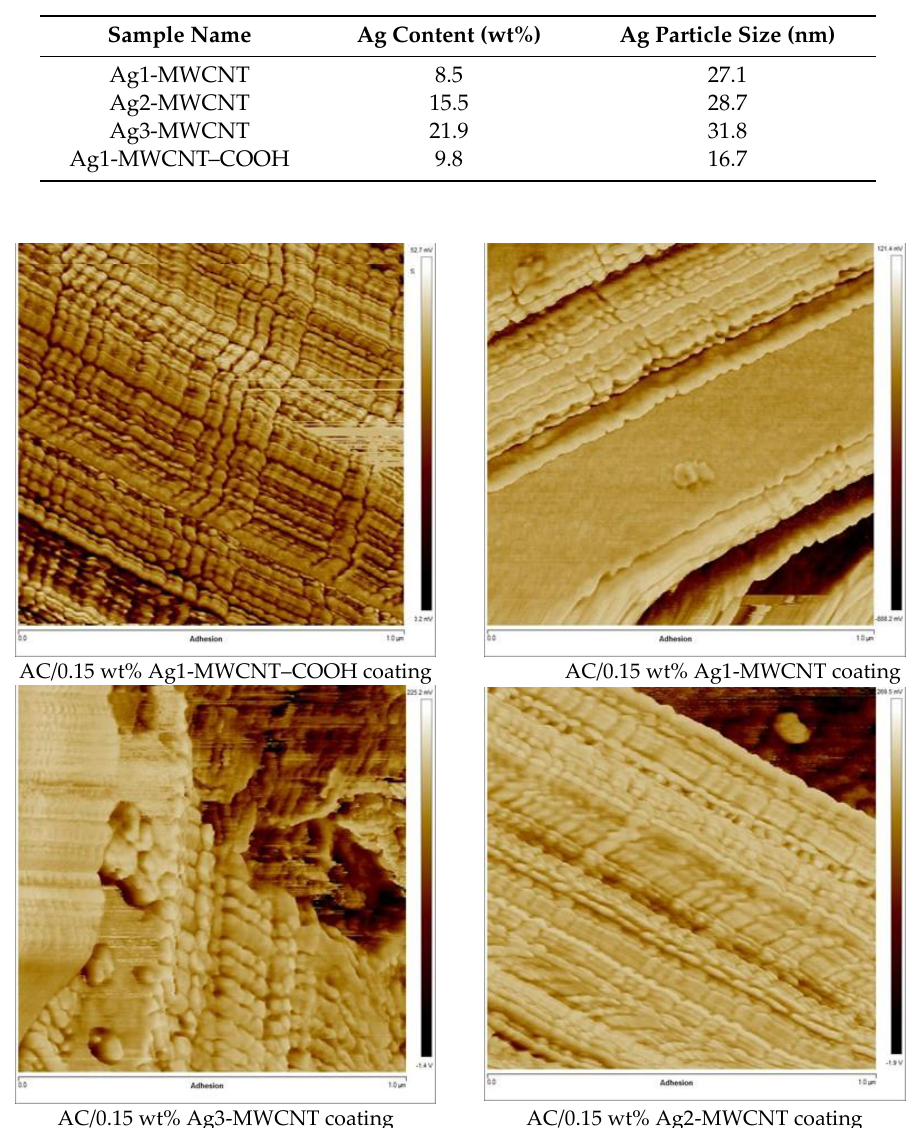
Figure 2. AFM adhesion force maps for composite coatings with different types of Ag-decorated MWCNTs. In all cases, image width scale = 1 um.